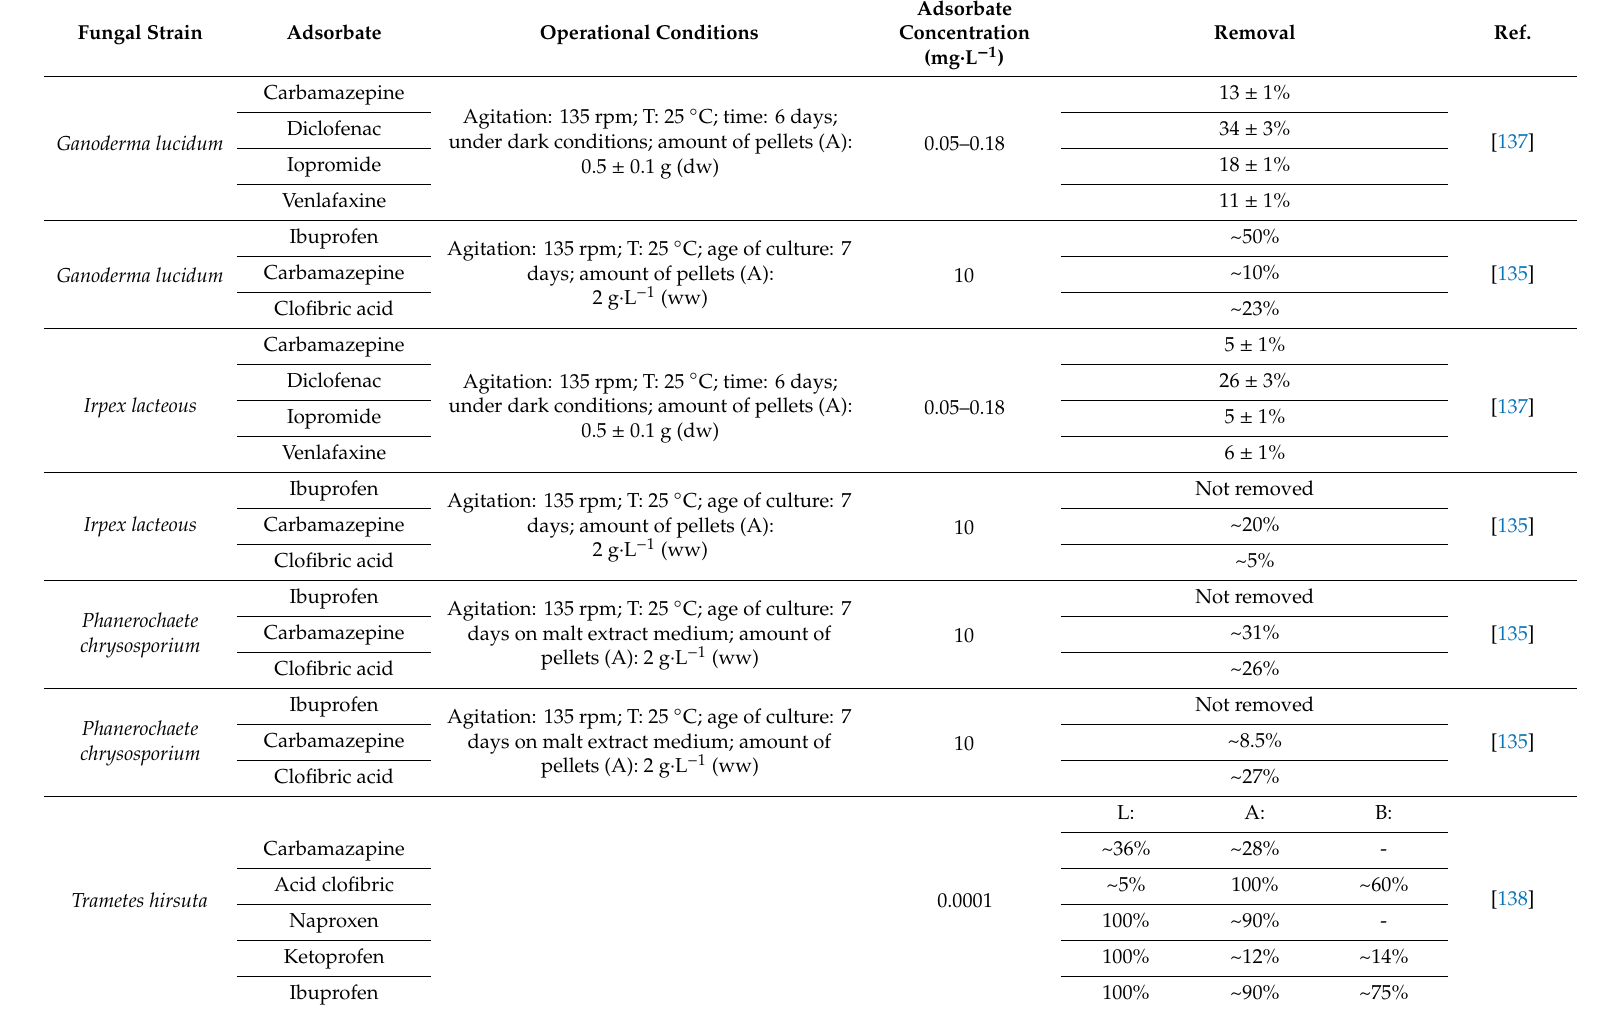
Table 6. Biosorption of pharmaceutical compounds by fungal